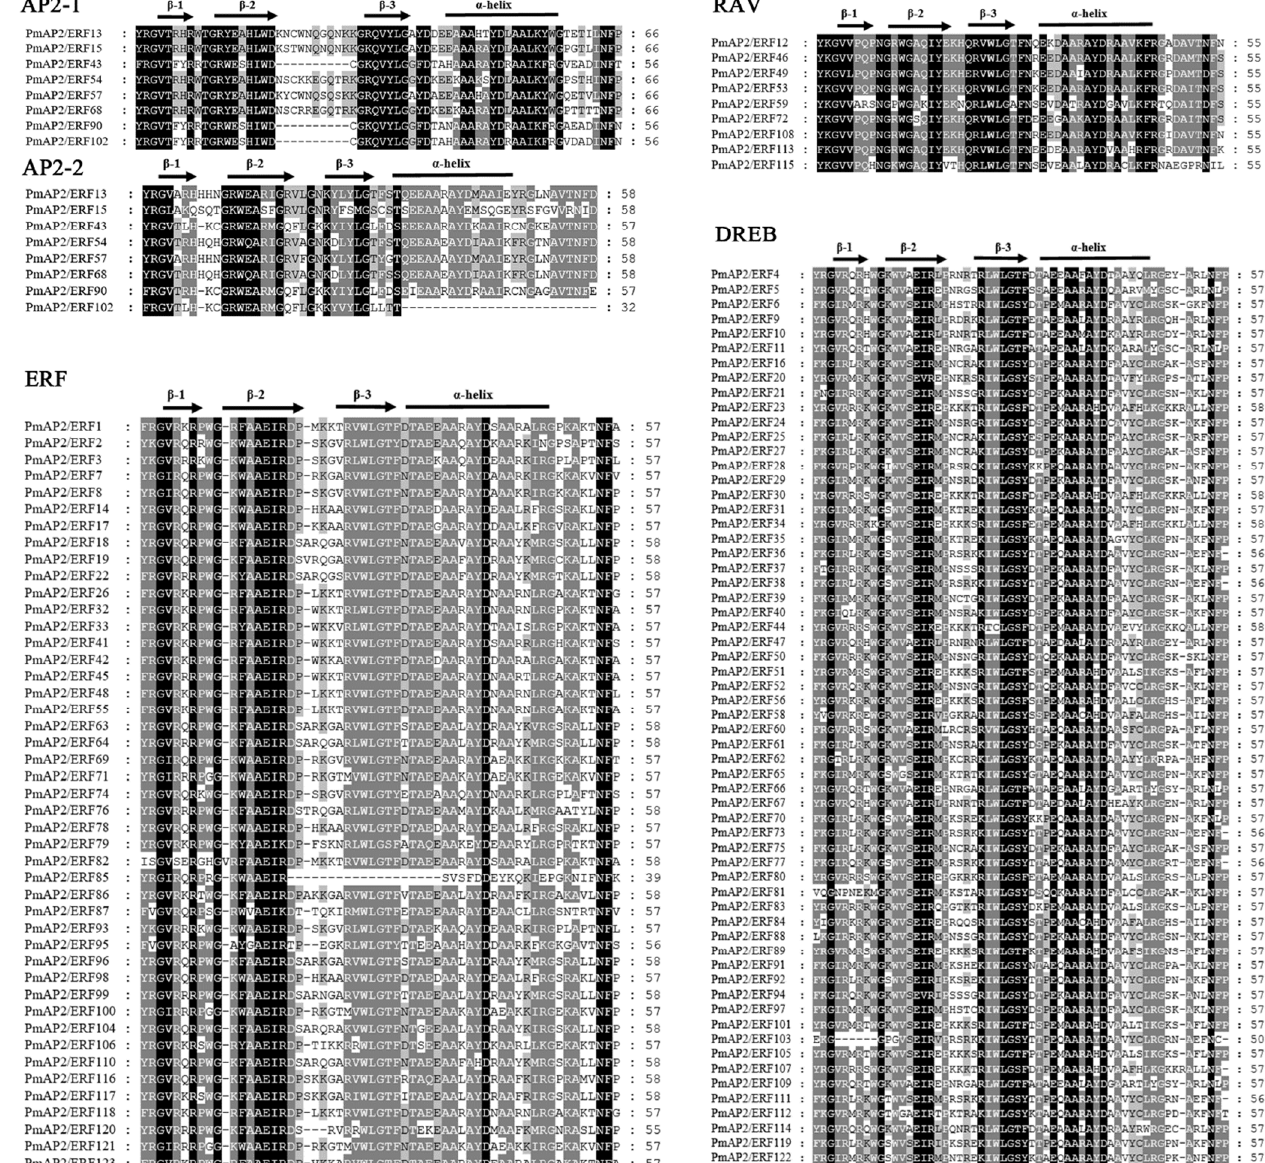
Figure 2. Multiple sequence alignment of AP2 structural domain proteins from each subfamily of PmAP2/ERFs. The sequence comparison results of AP2 structural domain proteins of AP2, RAV, ERF, and DREB subfamilies are shown in the figure, where AP2 subfamily contains two AP2 structural domains, AP2-1 and AP2-2, respectively. Arrows represent β-sheets and horizontal lines represent α-helix.